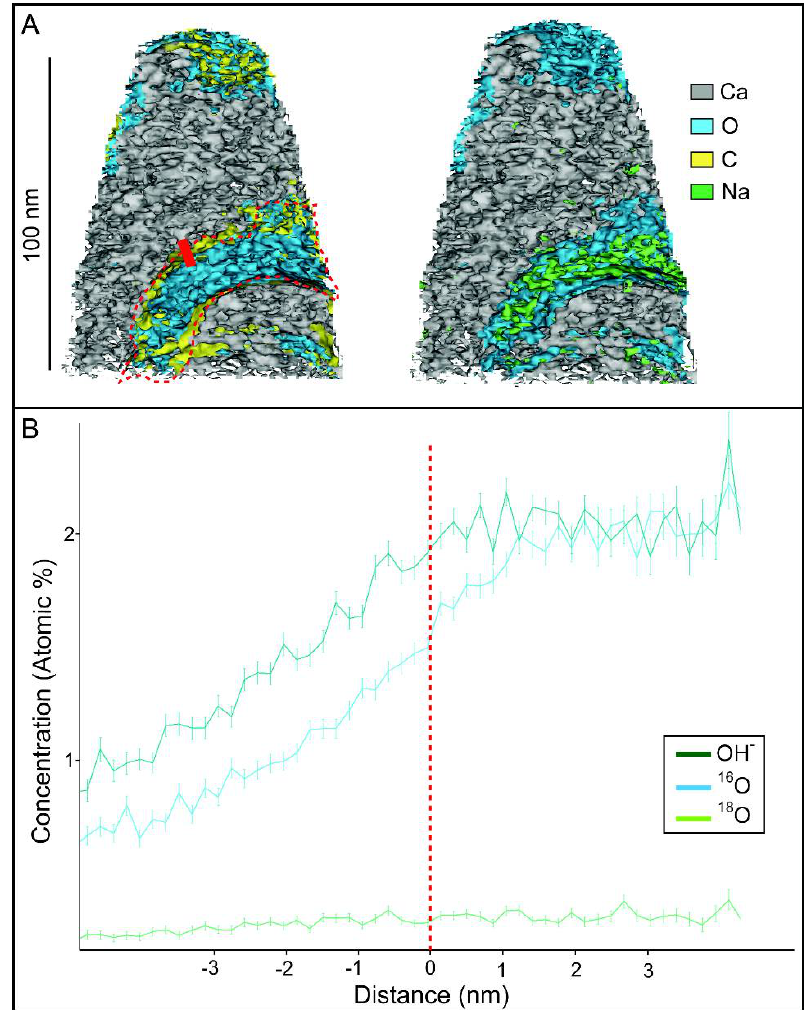
Figure 5. Chemical composition of the IOM from the calcitic layer. ( A ) 3D elemental isoconcentration reconstructions of a calcite tip (specimen 269), indicating the presence of regions enriched in oxygen ( 16 O) and carbon ( 12 C) (blue-yellow), and depleted in calcium, corresponding to the organic fraction. The central region (within the dashed red line) is also sodium-depleted (green; on right image; Na <0.3%); ( B ) Proxigram of the concentrations (in atomic %), across the mineral-organic interface (thick red line in ( A )) for the region highlighted by the dashed red line in ( A ), with zero marking the interface (mineral on the left, organic on the right; IOM region inside dashed red line in ( A ) for reference). Note the increase in 16 O and OH − concentrations inside the organic phase.